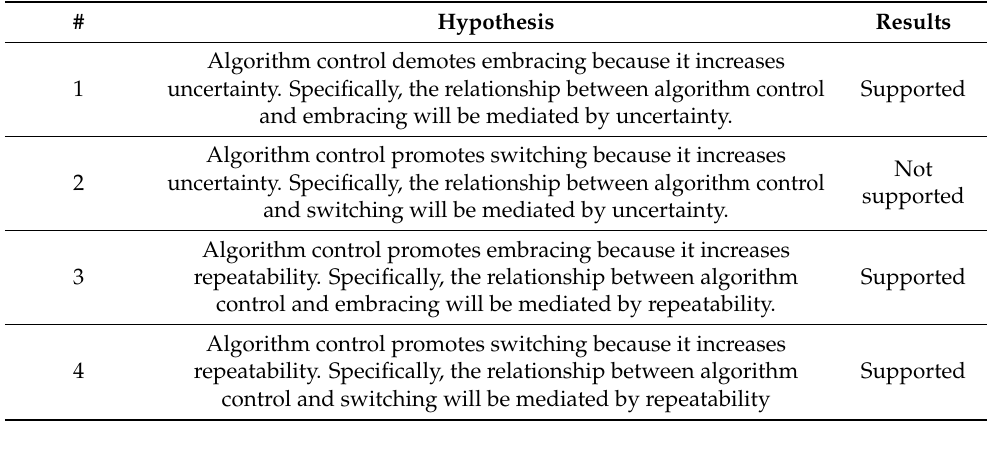
Table 3. Summary of Testing Hypotheses.